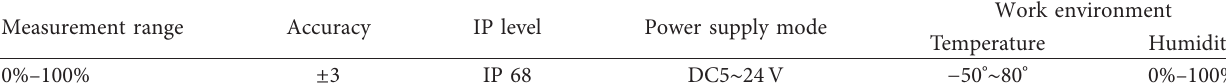
Table 5: Specifications of moisture content sensors.